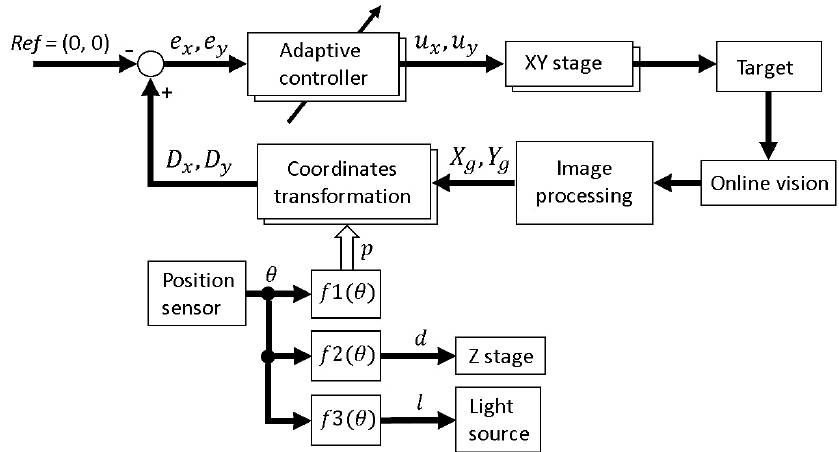
Figure 5. Block diagram for the developed microrobotic platform.